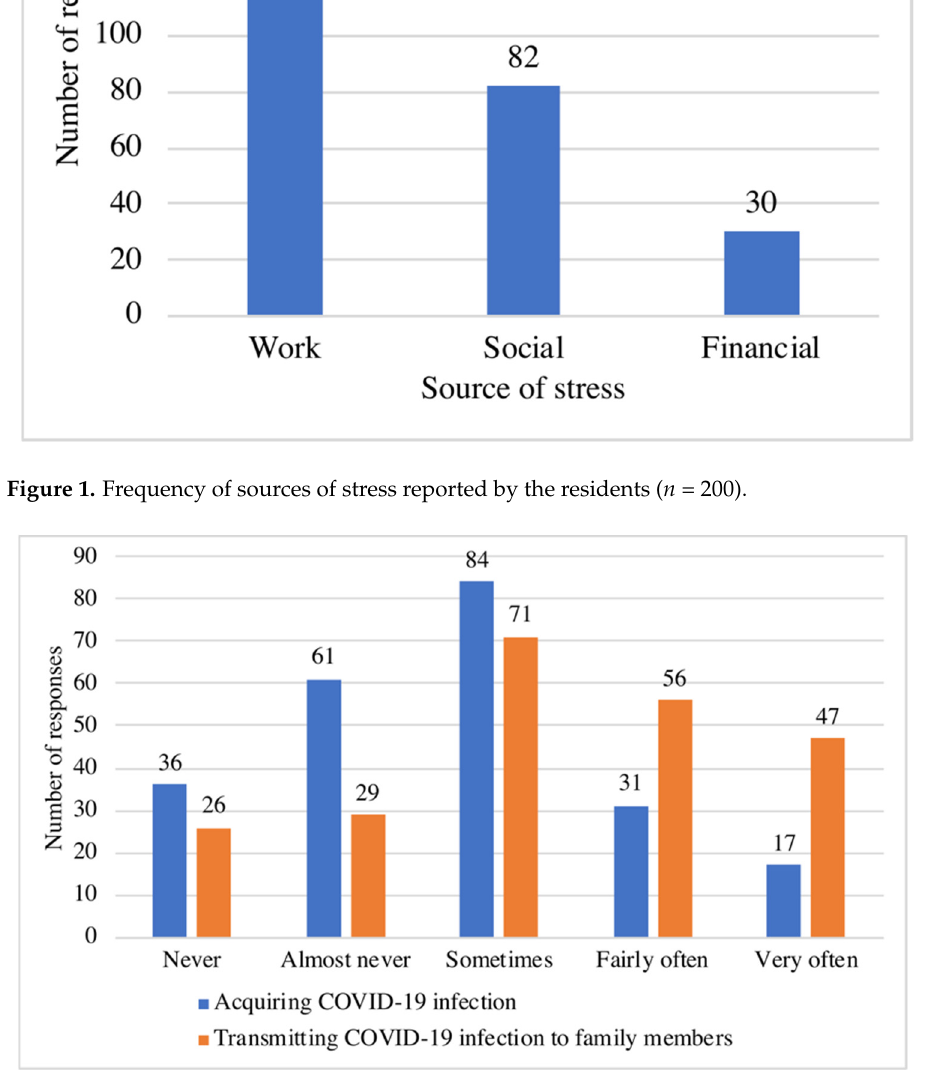
Figure 2. Residents’ responses regarding their concerns about COVID-19 infection ( n = 229).